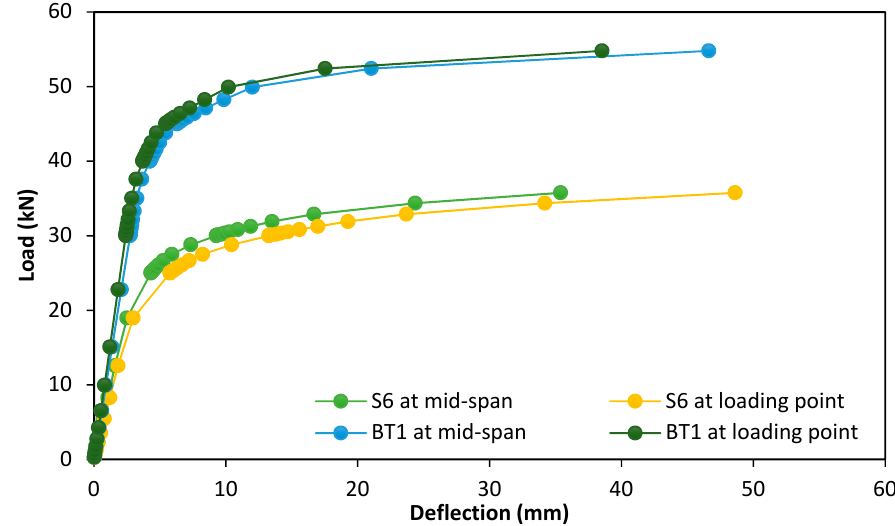
Figure 14. Load ‐ deflection curve of the second group specimens in parametric case studies. Figure 14. Load-deflection curve of the second group specimens in parametric case